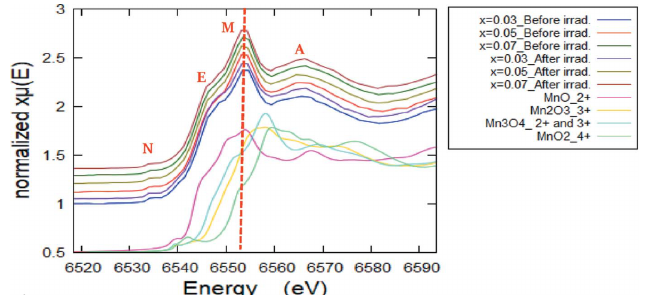
Figure 5 Normalized fingerprint XANES spectra of the pristine and (cid:2) -irradiated